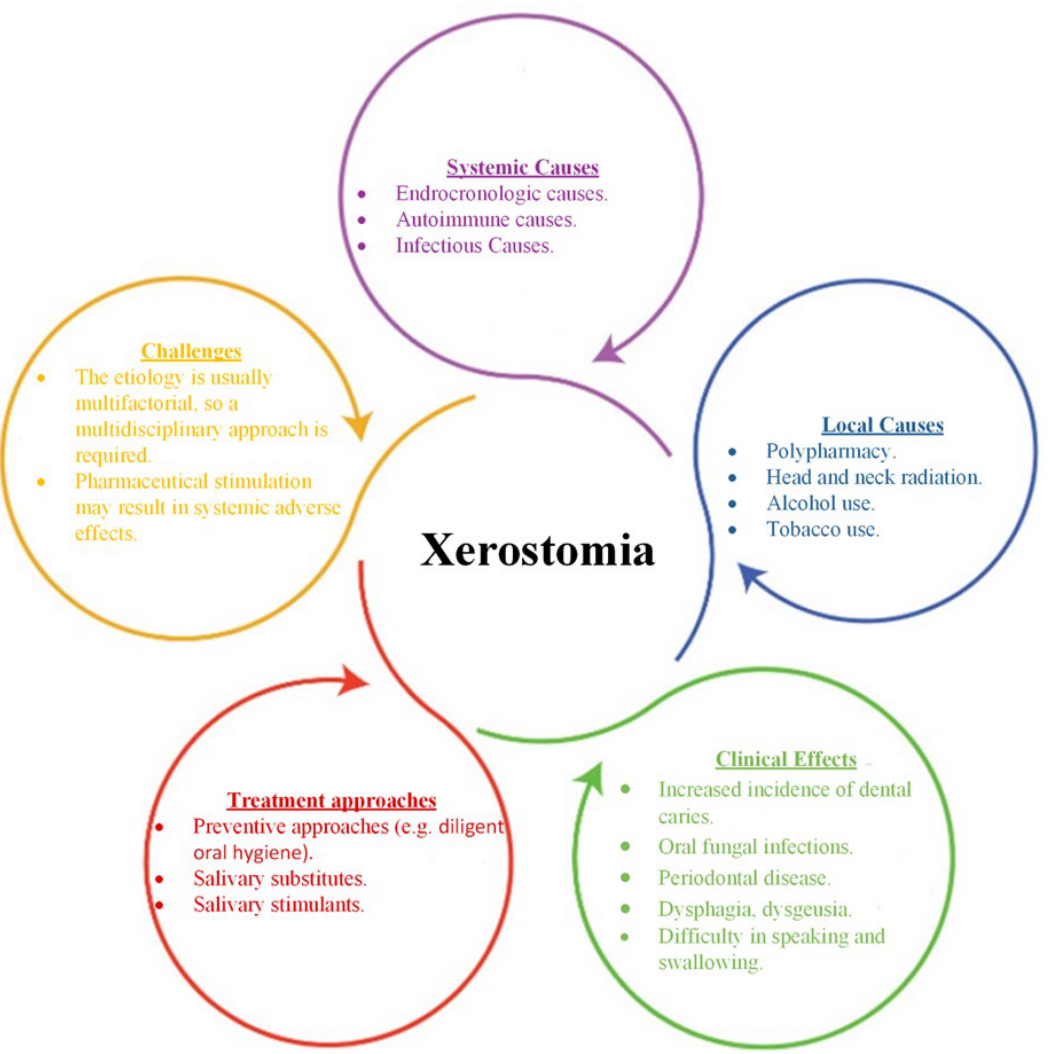
Figure 1. The most important aspects of xerostomia in terms of systemic and local causes, clinical effects, treatment approaches and faced challenges.